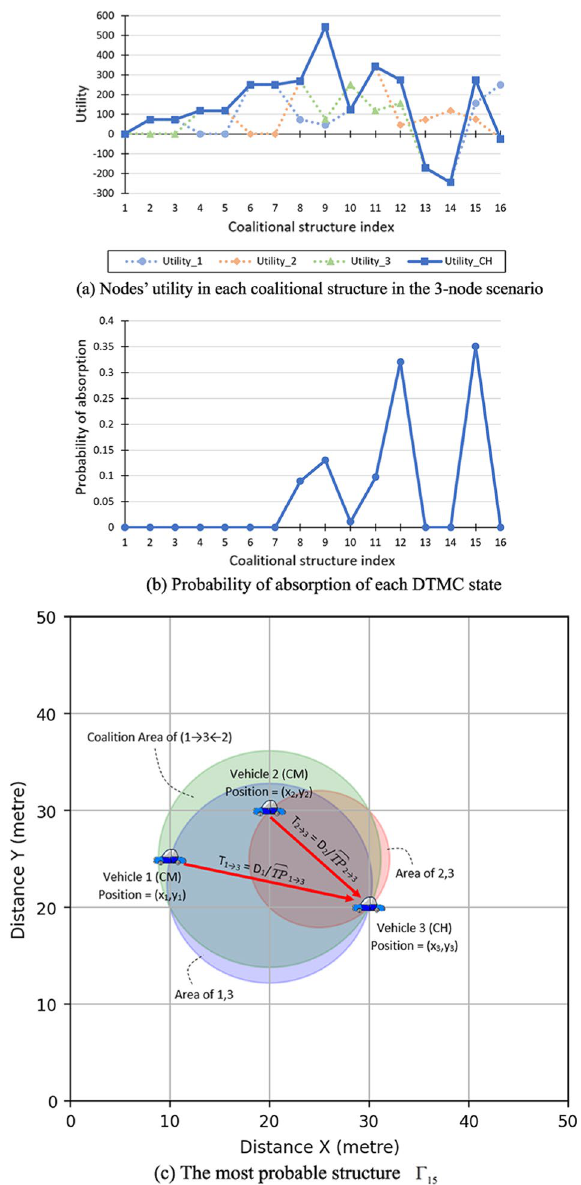
Fig. 4 DTMC results of three vehicles with weight coefficients α = 2 , τ = 1